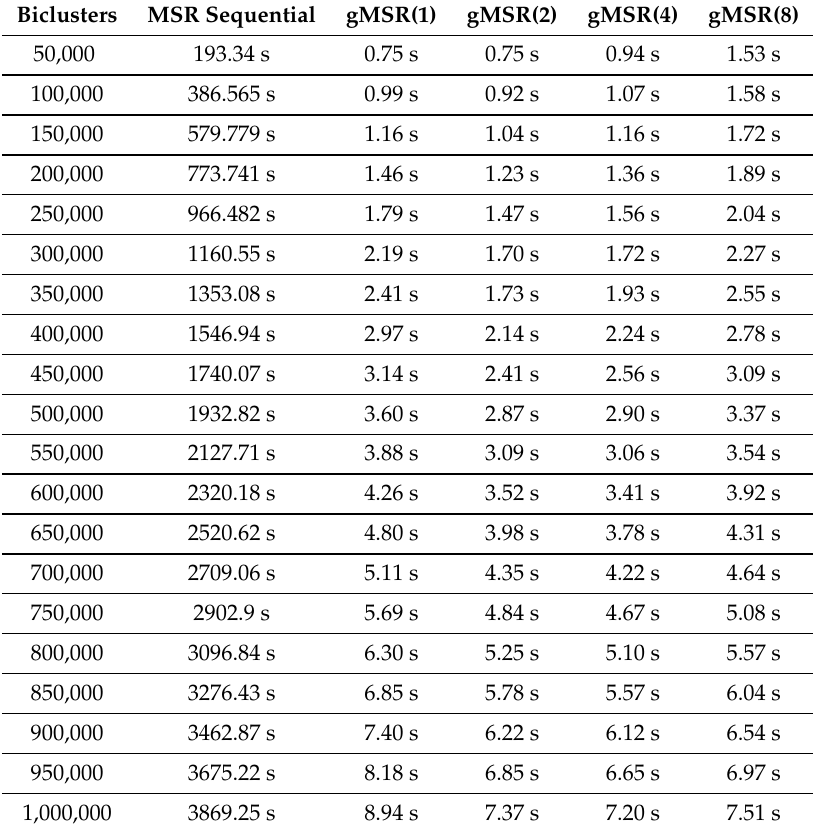
Table A1. This table shows the execution times in seconds for the processing of synthetic biclusters datasets when the number of biclusters increases from 50,000 to 1,000,000 (first column). The second column corresponds to the sequential implementation of the MSR measure. The other four columns represents the gMSR executions using 1, 2, 4 and 8 GPU devices, respectively. As it can be observed, gMSR outperforms the sequential version and scales optimally.